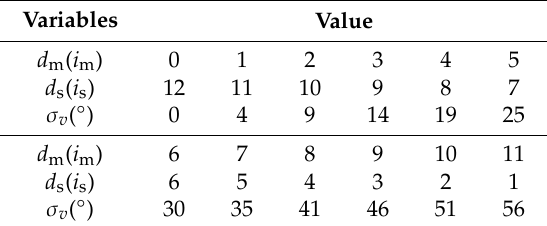
Table 1. Discrete sector angle switching table.